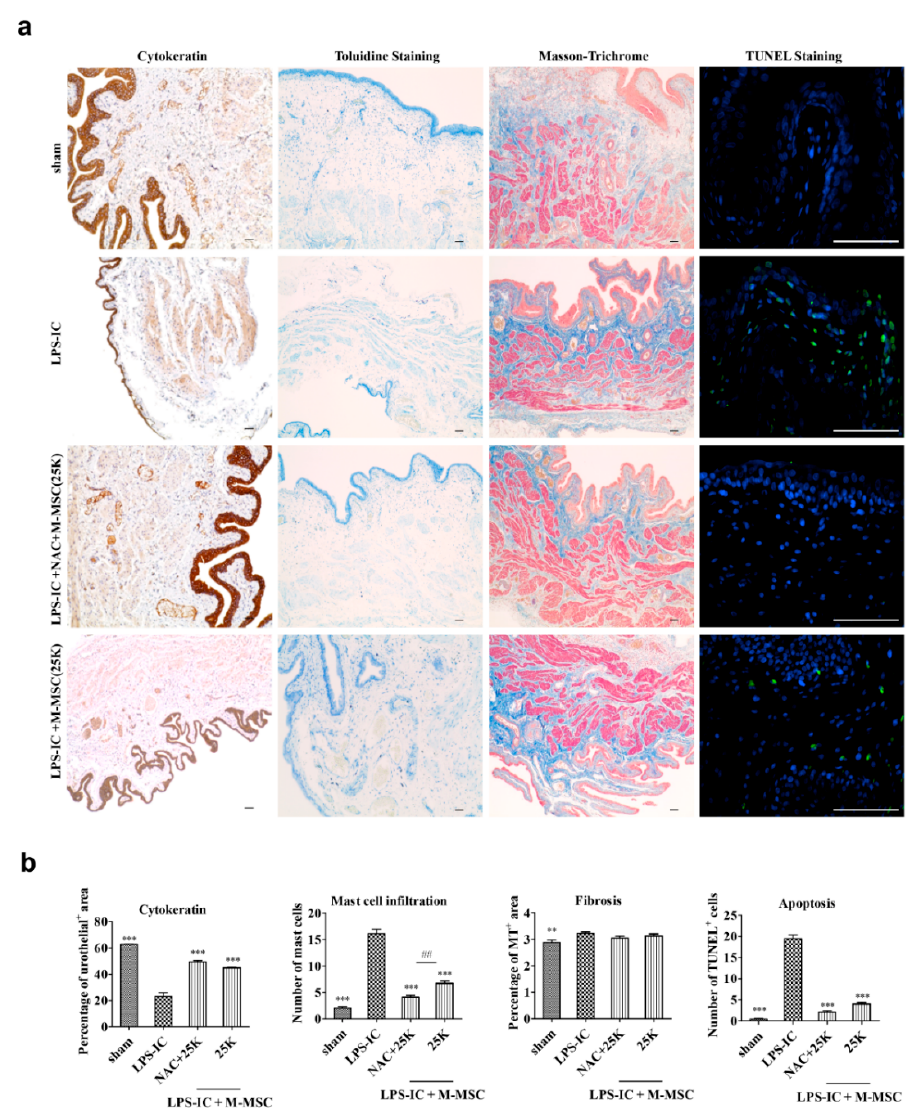
Figure 5. Histological analysis of the effect of N-acetylcysteine (NAC) and M-MSCs pharmacologic therapy on the bladder of the lipopolysaccharide-induced cystitis (LPS) rat model. ( a ) The histological analysis of urothelium, mast cell infiltration, fibrosis, and apoptosis in the bladder tissues of the indicated groups. Nuclei were stained with 4 ′ ,6 ′ -diamino-2-phenylindole (blue). ( b ) Quantitative data of each staining are presented on the right side of the indicated representative pictures. All of the quantitative data were normalized to those of the sham group and are presented as a dot plot with a mean ± standard error of the mean ( n = 15). * p < 0.05, ** p < 0.01, and *** p < 0.001 compared with the LPS using the Bonferroni post-test.